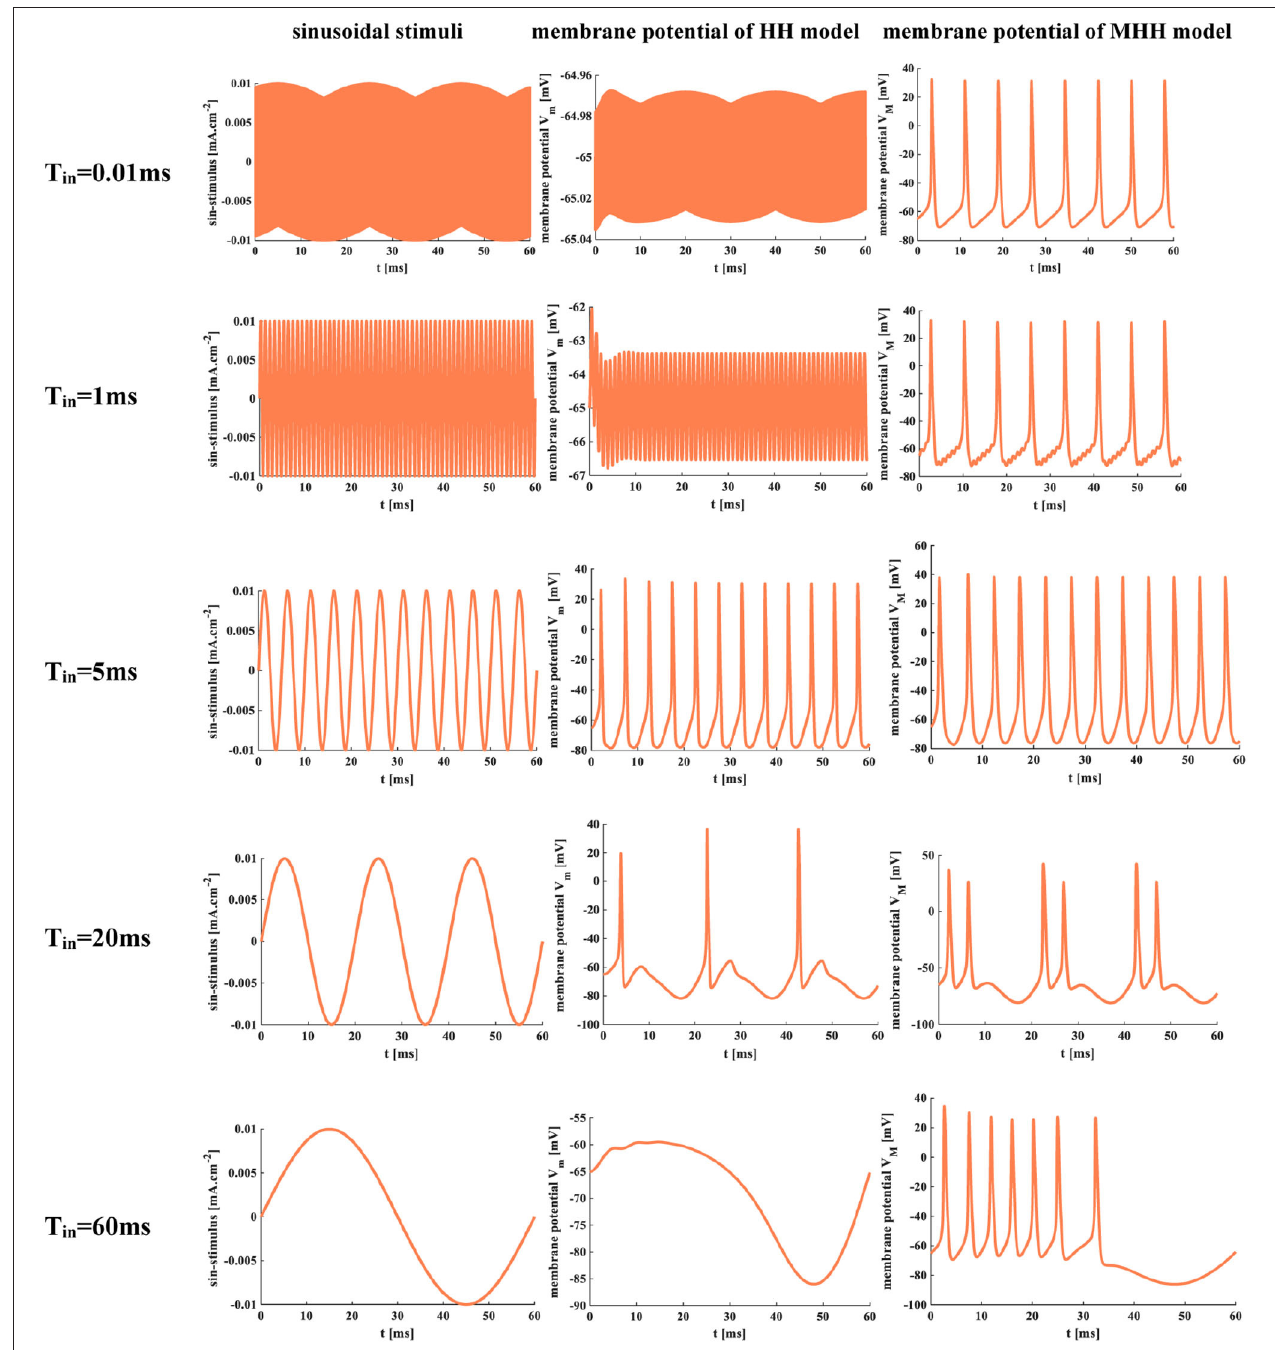
FIGURE 14 | The time periods of the sinusoidal signal. T in = 0.01 ms, T in = 1 ms, T in = 5 ms, T in = 20 ms, T in = 60